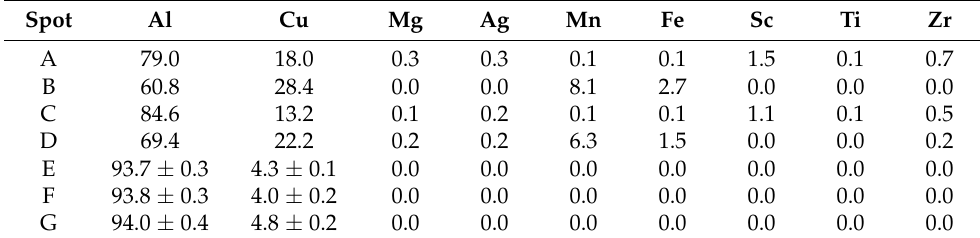
Figure 5. Backscattered electron (BSE) images of three Al–Cu–Mg–Ag alloys before the creep analysis points). Table 4. EDS results of the phases indicated in Figure 5 (in wt